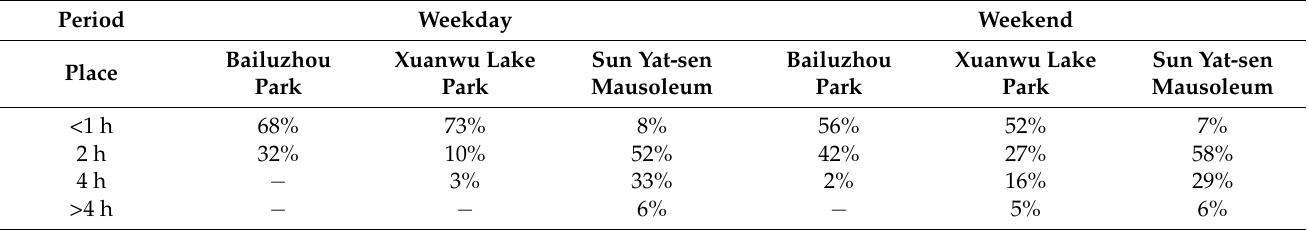
Table 2. Typical traveling time of park visitors, which was used to determine the length of stay for users in the park. Period